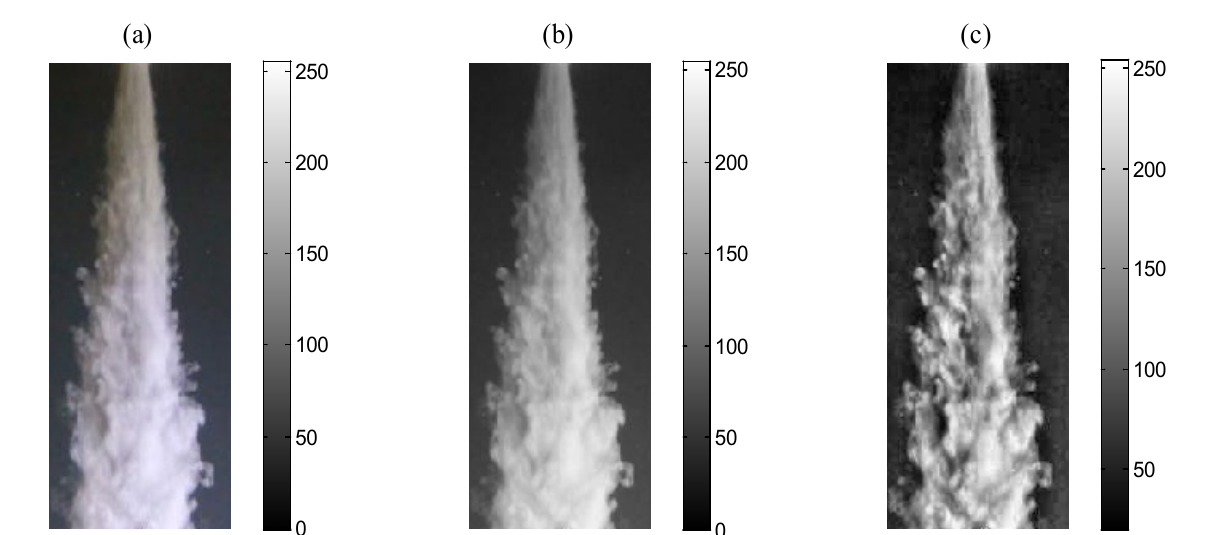
Figure 2. A sample of the ( a ) original image, ( b ) image after background subtraction, and ( c ) enhanced image using adaptive histogram equalization.